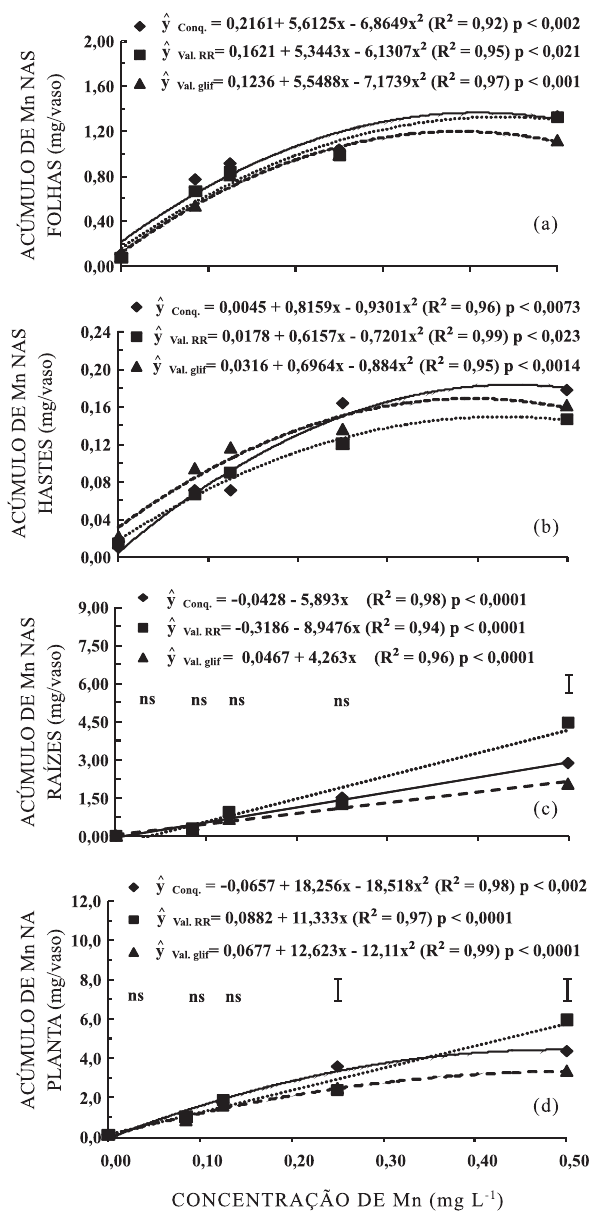
Figura 1. Acúmulo de Mn em folhas (a), hastes (b), raízes (c) e total na planta (d) por soja das cultivares Conquista e Valiosa RR com ou sem aplicação de glifosate via foliar, em função de doses de Mn na solução nutritiva. Barra vertical representa o valor do DMS pelo teste t a 5